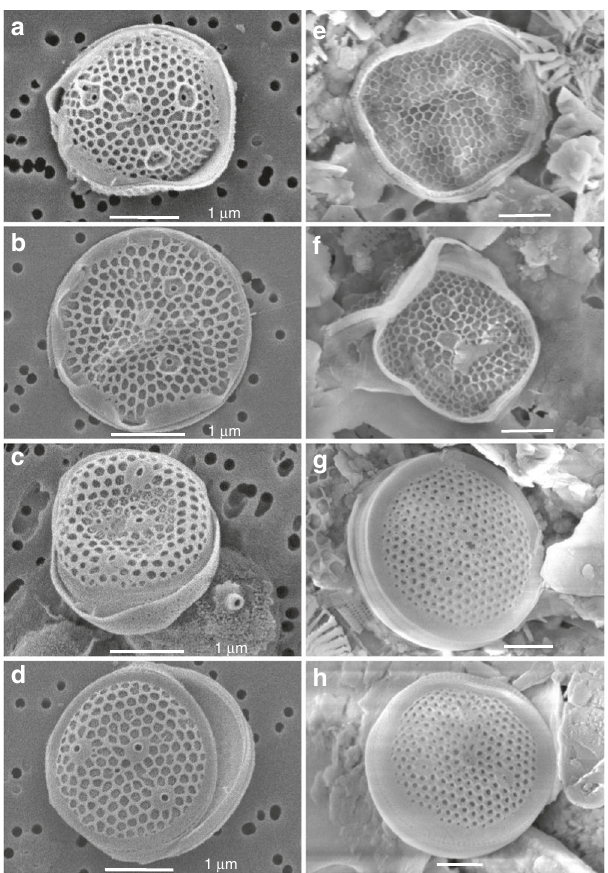
Fig. 5 Minidiscus comicus and Minidiscus trioculatus in surface water and sediment trap samples during spring 2013. ( a , b ) M. comicus , ( c , d ) M. trioculatus observed in scanning electron microscopy (SEM) at station 99, located at 42°N, 5°E on 24 th April 2013 at the surface. ( e , f ) M. comicu s, ( g , h ) M. trioculatus observed in SEM in three deep sediment traps samples (2400 m) at 42°N, 4.5°E covering 30 th March to 22 nd May 2013. All scale bars are 1 µ m